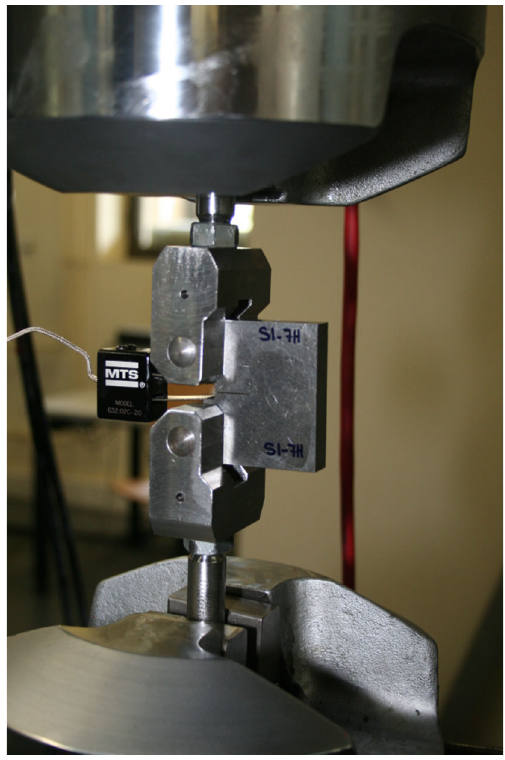
Fig. 1 Round compact tensile test specimen and tensile clevises and